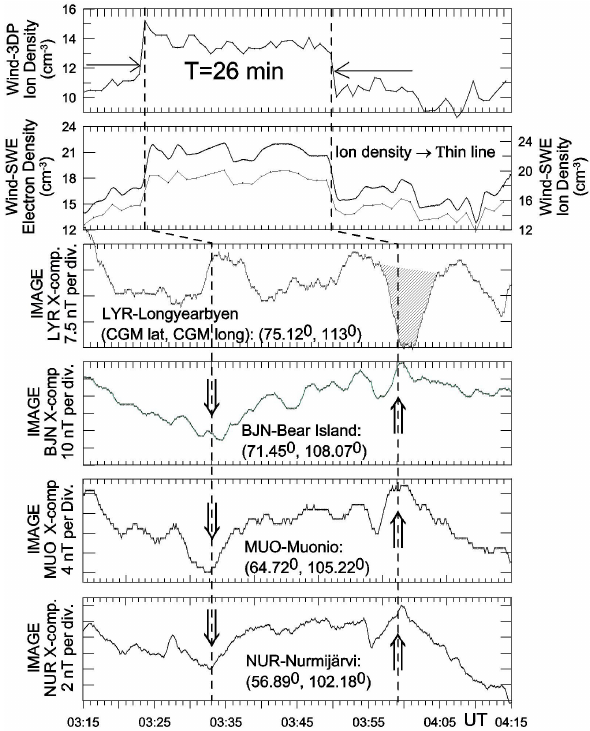
Fig. 4. Almost similar format as in Fig. 3 for the second long- lasting pressure pulse episode. The bipolar feature is seen for all the IMAGE array stations, although with decreasing amplitude at decreasing latitudes. However, for the highest latitude LYR station only the negative excursion is